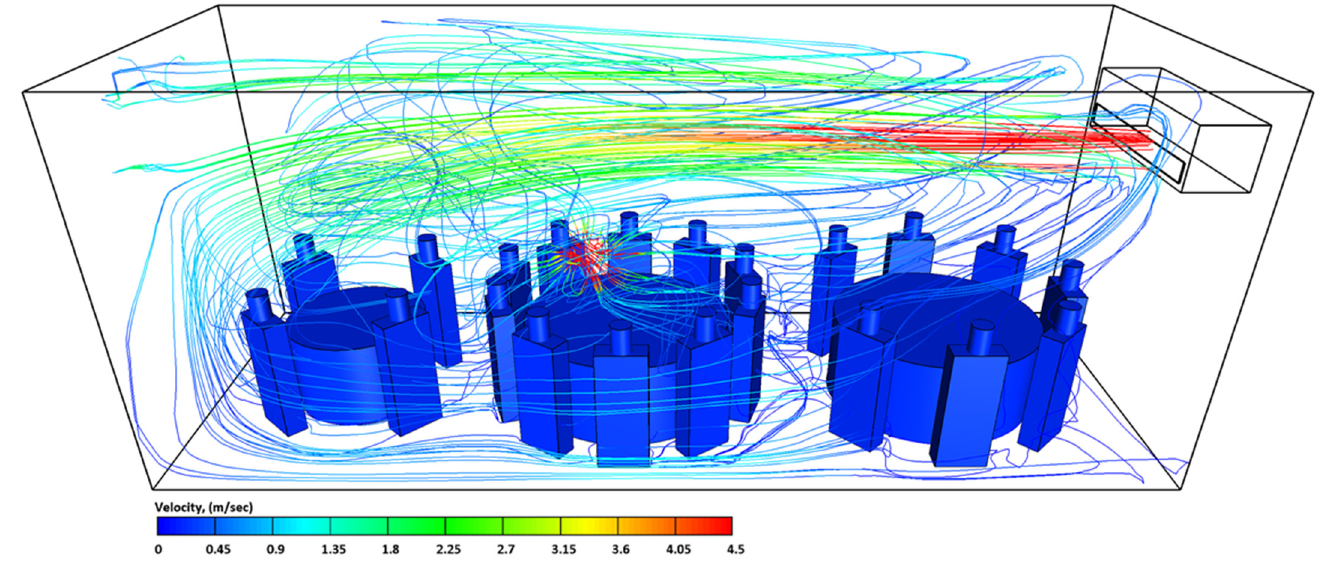
Figure 11. The airflow streamlines velocities in the computational domain at t = 603 s for case-2.